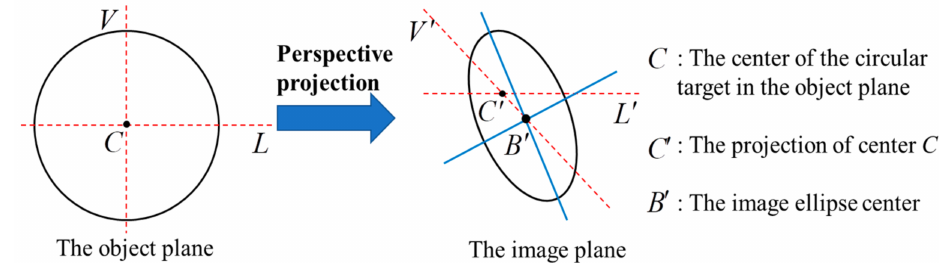
Figure 3. Eccentricity error of circular target caused by perspective imaging. C is the center of the circular target in the object plane; C (cid:48) is the true projected center of the circular target; B (cid:48) is the center of this image ellipse; the deviation between C (cid:48) and B (cid:48) is defined as eccentricity